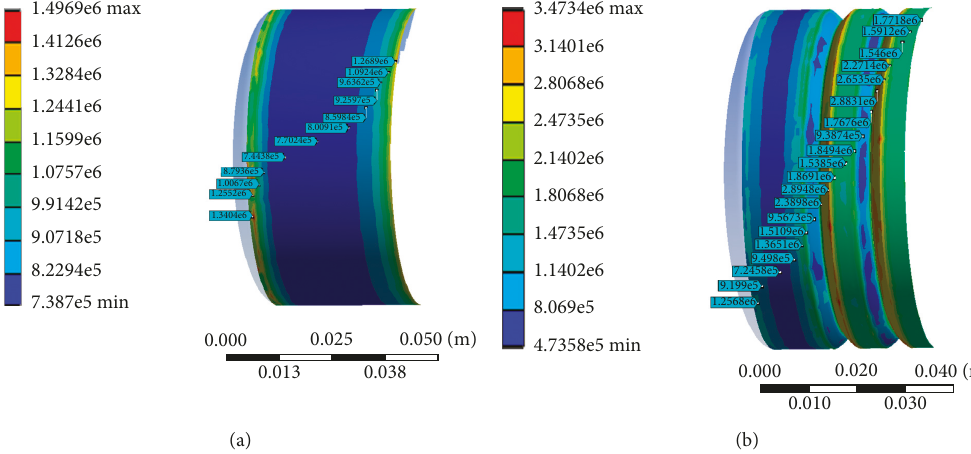
Figure 10: The surface pressures from the lip mouth to the root: (a) standard piston; (b) bionic piston.